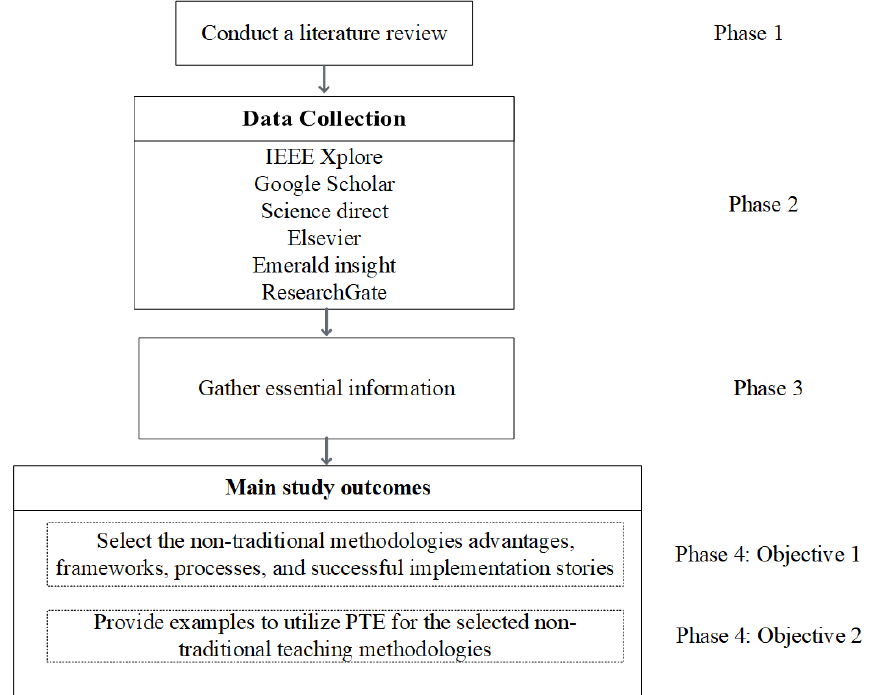
Figure 1. Research methodology.